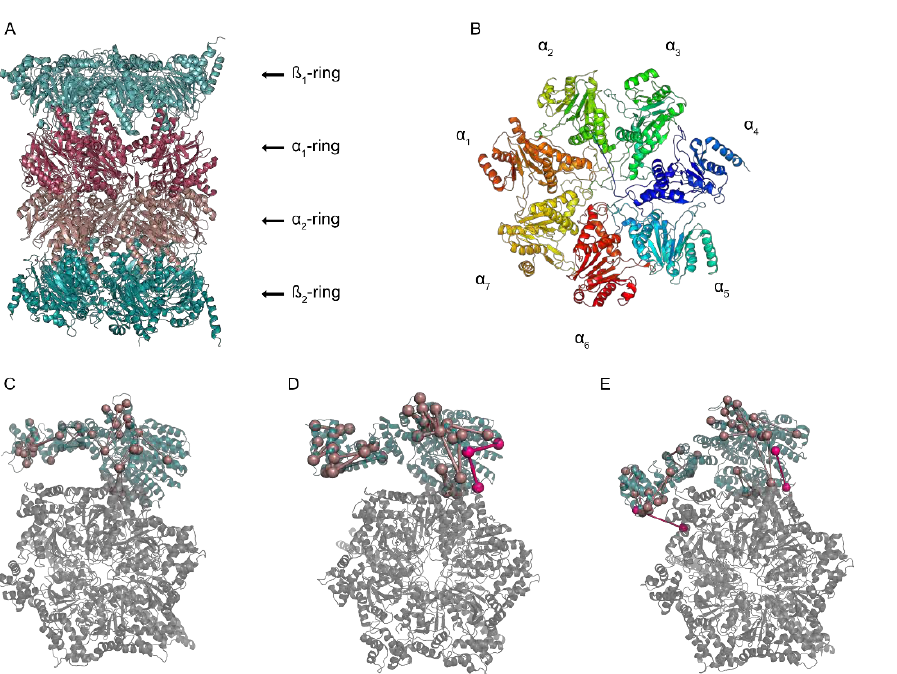
Figure 1. Structure of the 20S proteasome and its interaction with the 19S. ( A ) Side view of the 20S proteasome showing the four rings (PDB: 5WVI). ( B ) Top view of the 20S proteasome with the seven subunits shown in different colors (PDB: 5WVI). ( C–E ) Crosslinks identified by cross-linking mass spectrometry (CLMS) between the AAA-ATPase heterohexameric ring and the RPN1 subunit of the 19S regulatory particle (PDB: 4CR2), adapted from Mendes et al 2019 [6].